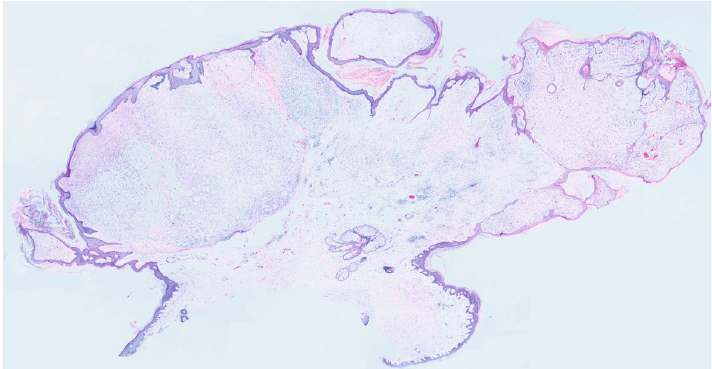
Figure 1: Scan shows a pedunculated neoplasm con fi ned to the dermis that is composed of mixed areas of hypercellularity and hypocellularity. The stroma varies with predominantly myxoid areas and other foci that are more collagenous.